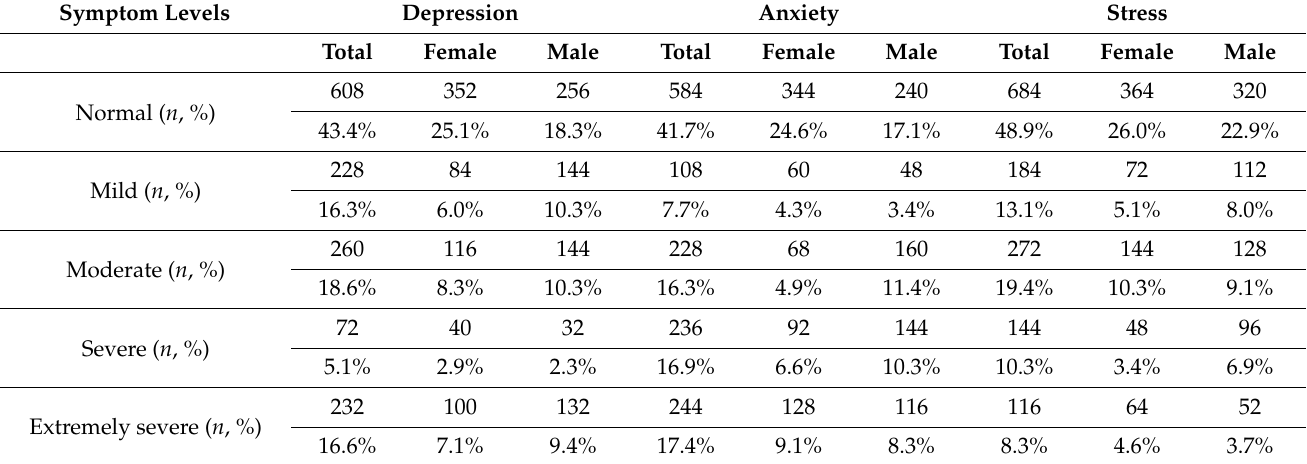
Table 2. The scores of Depression, Anxiety, and Stress (DASS